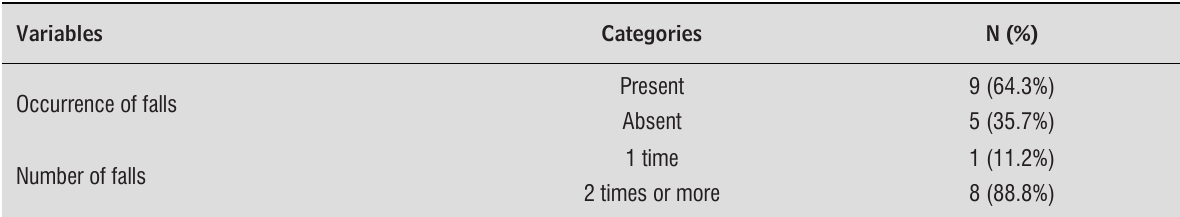
Table 2 - Variables to the occurrence of falls in elderly participating in interaction groups in Caxias do Sul City, RS State, 2011. (N = 14)